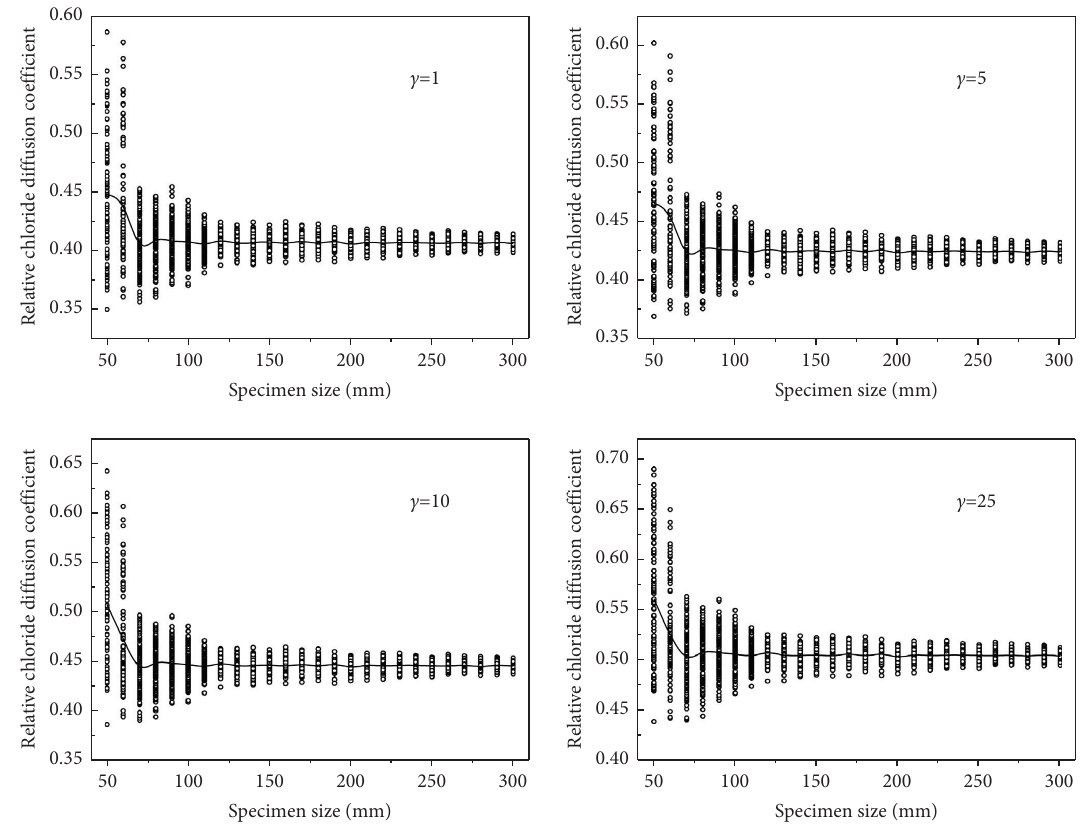
Figure 5: Relative chloride’s difusion coefcients in concrete at diferent sizes ( k �